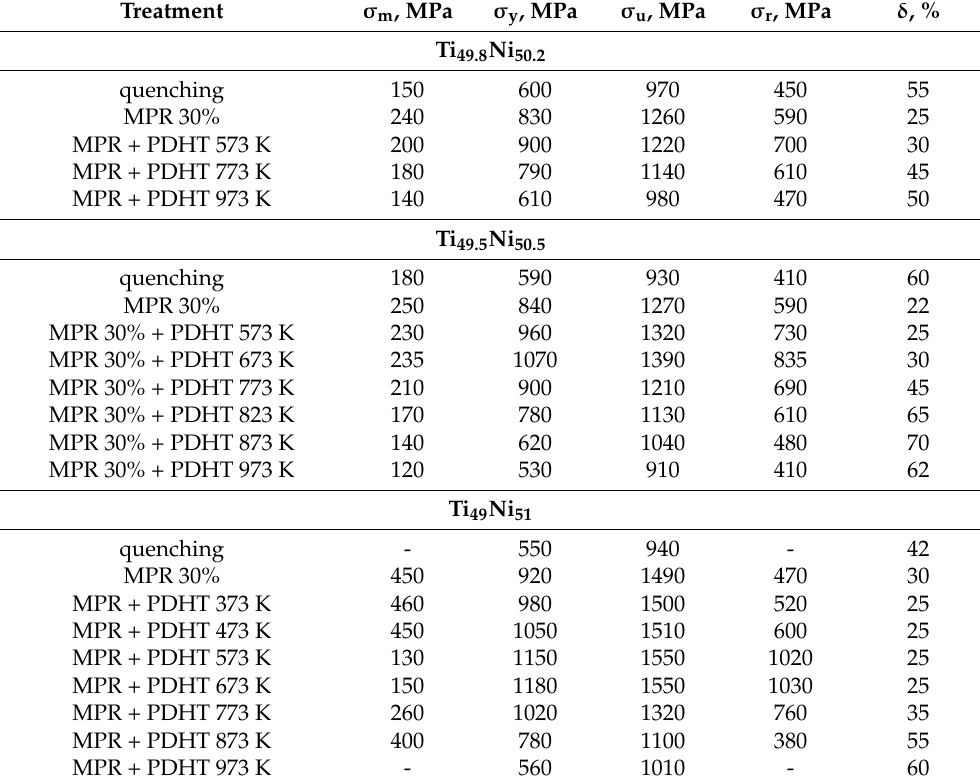
Table 6. Mechanical properties of the SME Ti 49.8 Ni 50.2 , Ti 49.5 Ni 50.5, and Ti 49 Ni 51 alloys after MPR and PDHT (1